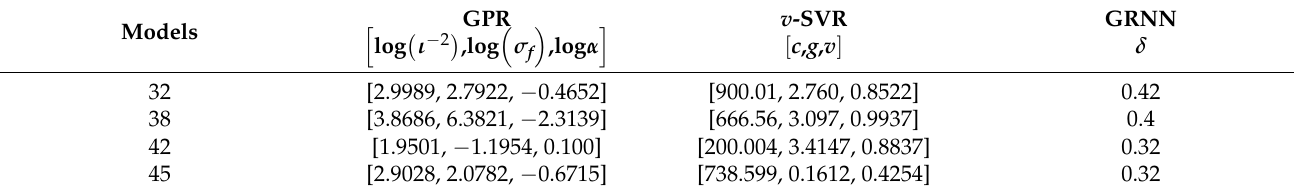
Table 3. The parameters of different algorithms for Lodalen